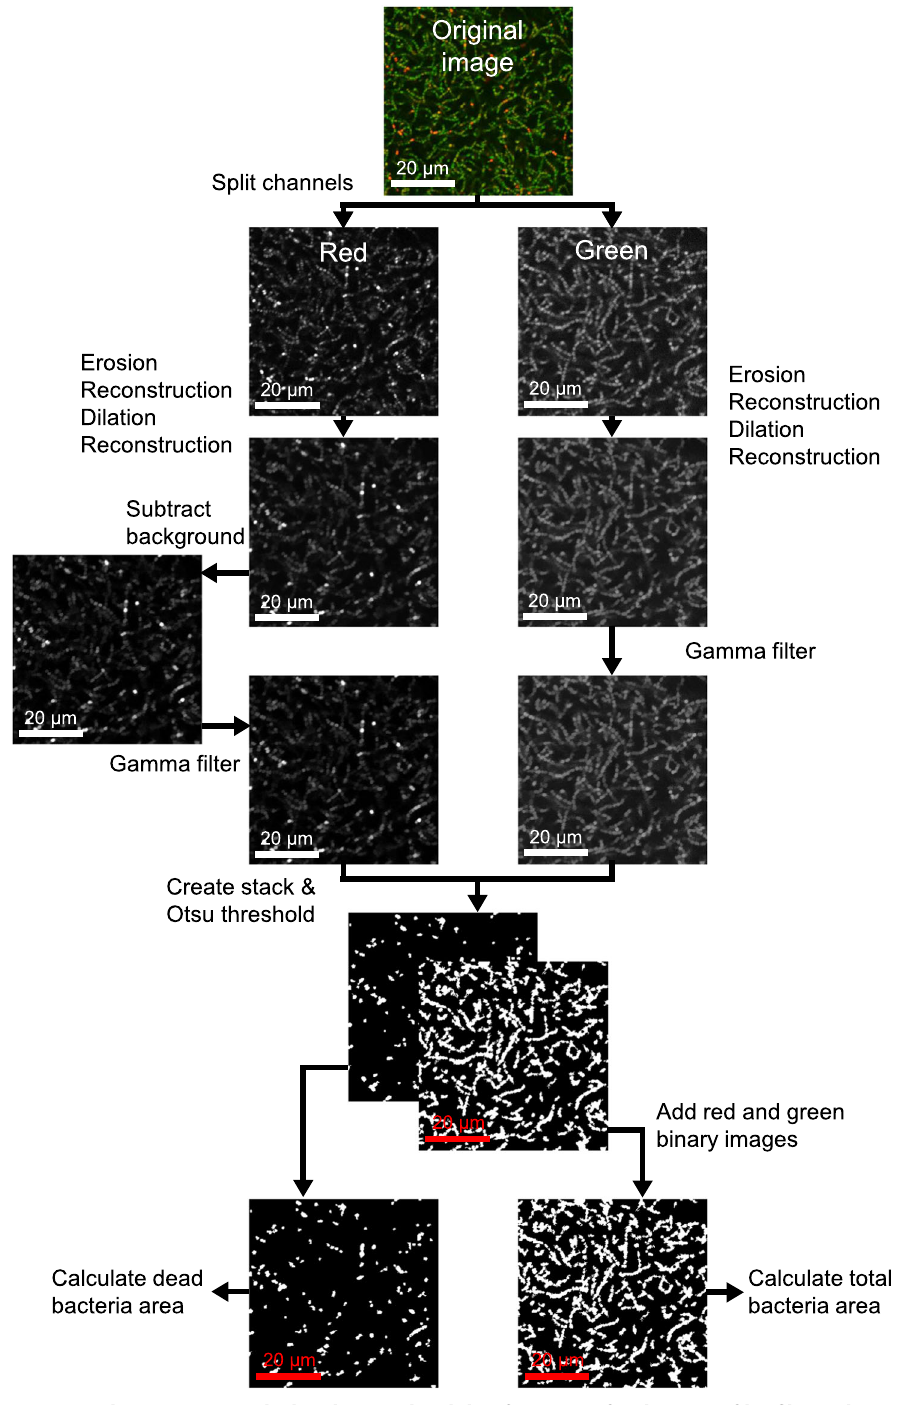
Fig. 1 Image analysis steps used in ImageJ to calculate bacterial viability from a confocal image of bio fi lm with LIVE/DEAD stain. Images taken from a representative S. sanguinis bio fi lm cultured for 48 h (20 µm scale bar). See Supplementary Information to implement the automated